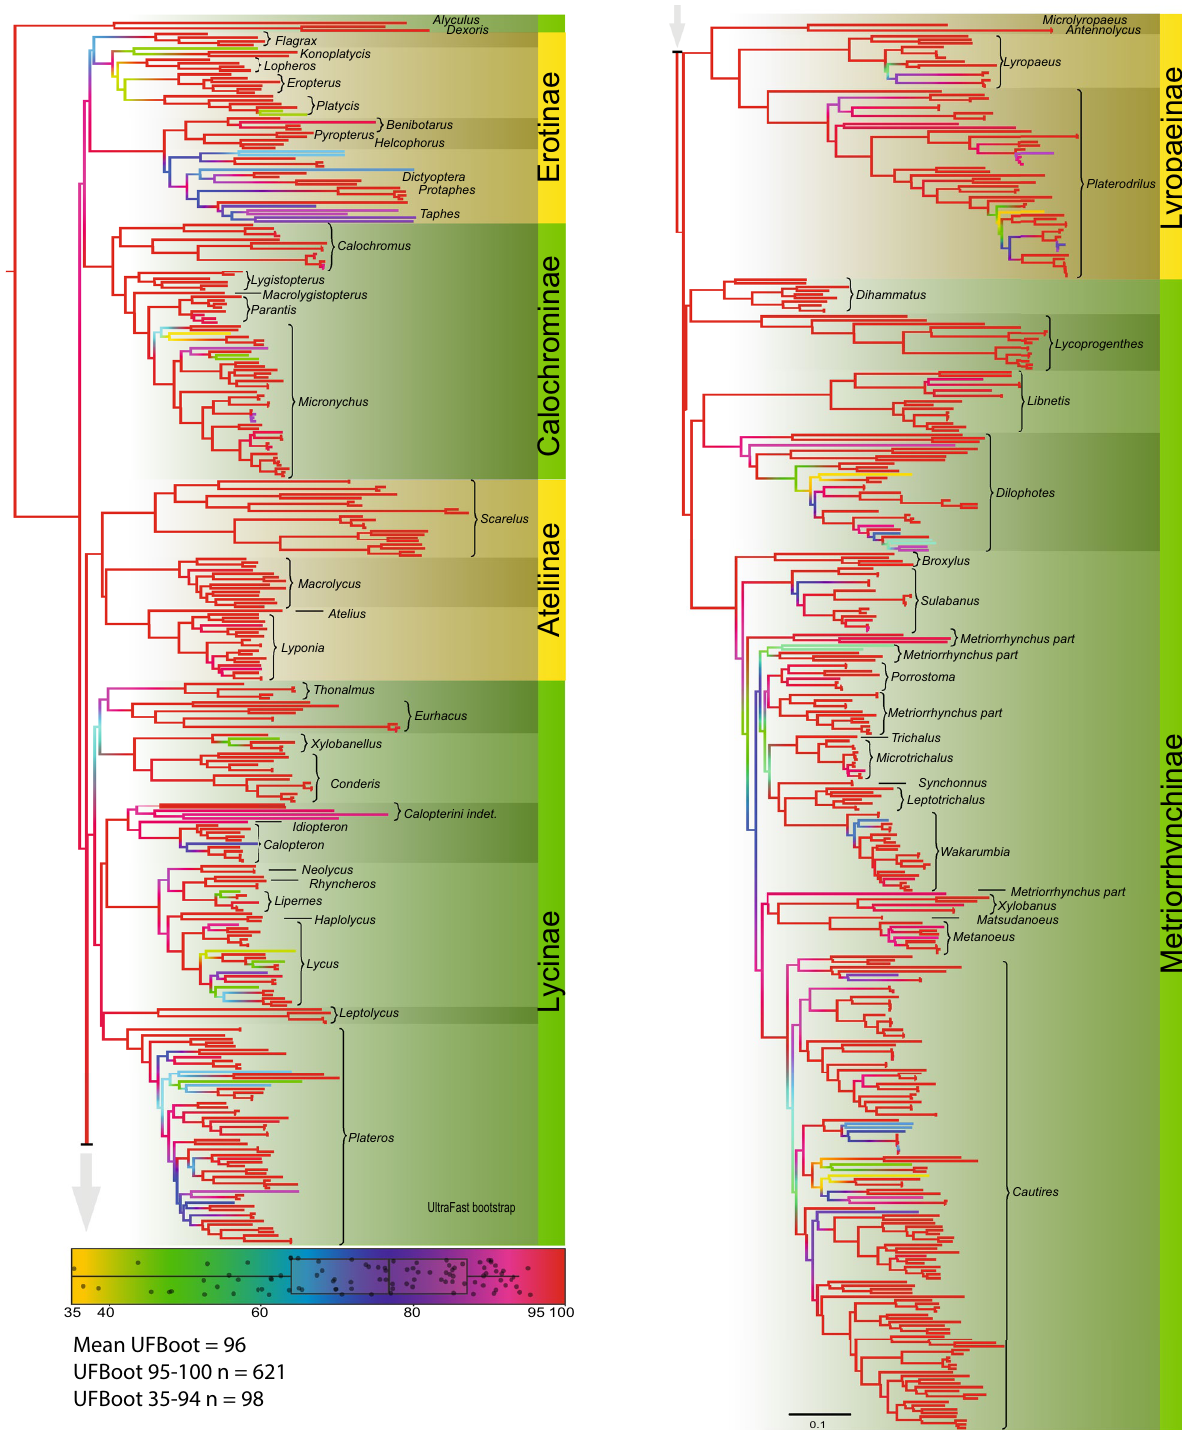
Figure 5. The phylogenetic tree of net-winged beetles recovered by the maximum likelihood analysis of five rRNA and mtDNA fragments and constrained by the relationships of 22 terminals for which are available genomic data. The constrained topology is shown in Fig. S915. The figure was produced in a whole by authors listed under the title of this